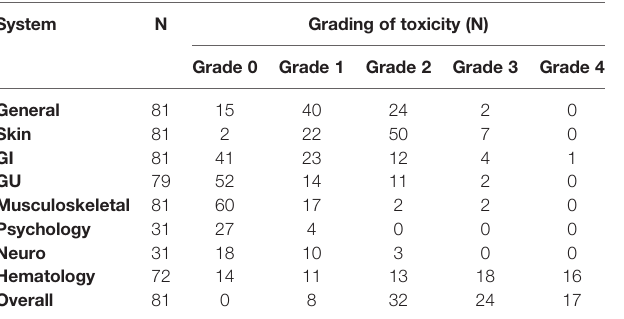
TABLE 3 | Acute toxicity report for all patients.